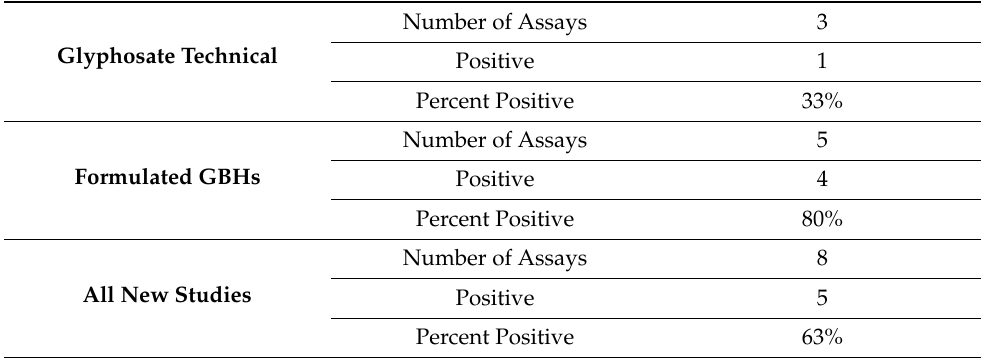
Table 5. Non-mammalian In Vitro Genotoxicity Assays Published Since the EPA and IARC Reviews of Glyphosate and GBH